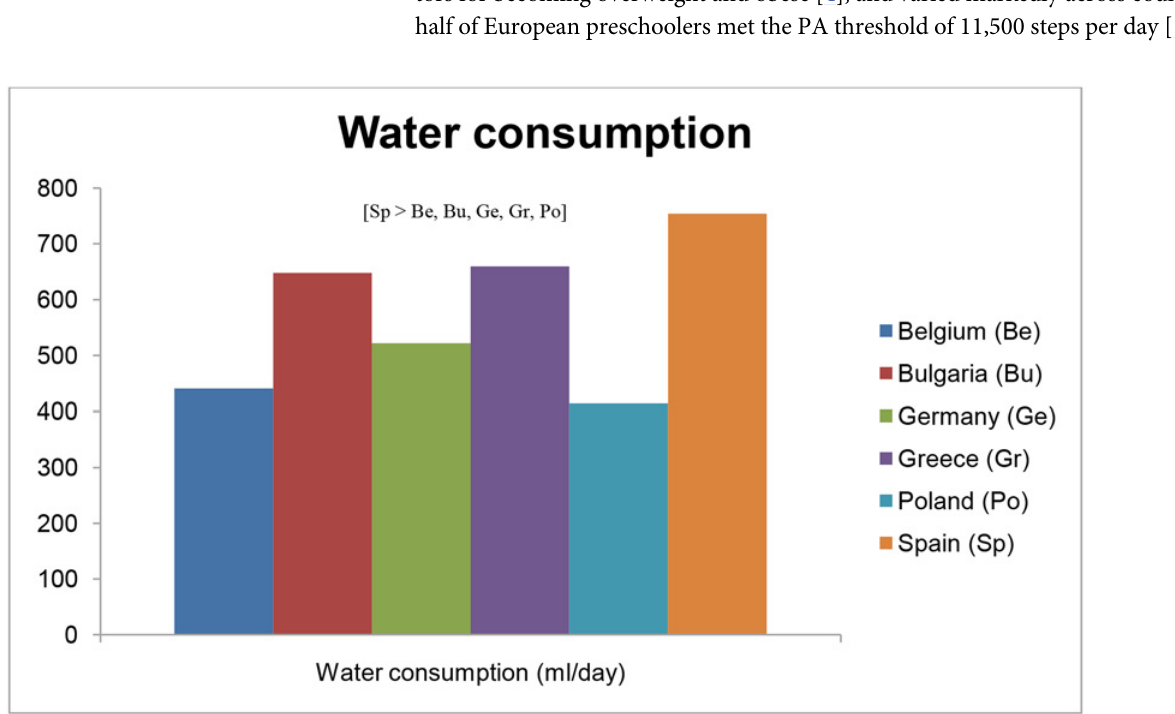
Fig 3. Differences in preschoolers ’ water consumption across